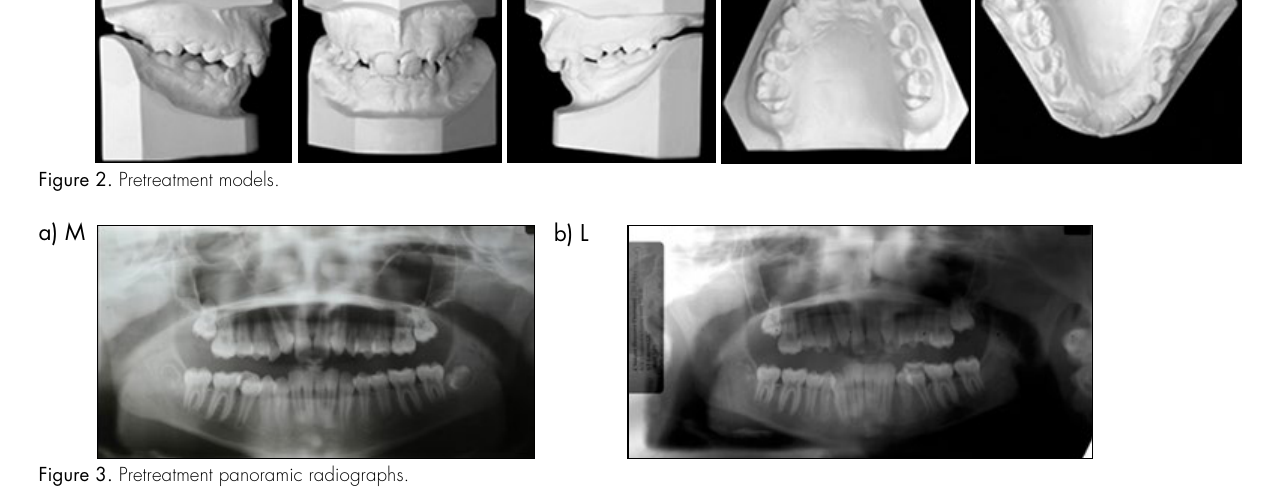
Figure 3. Pretreatment panoramic radiographs.